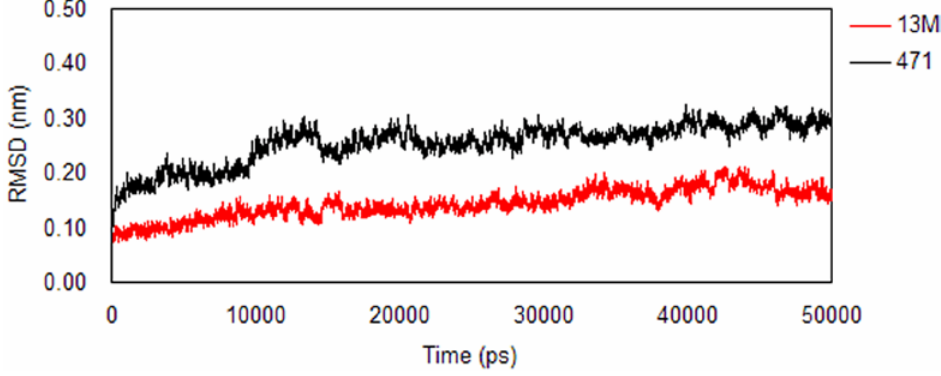
Figure 4. The root mean square deviation (RMSD) of Cα atoms for different